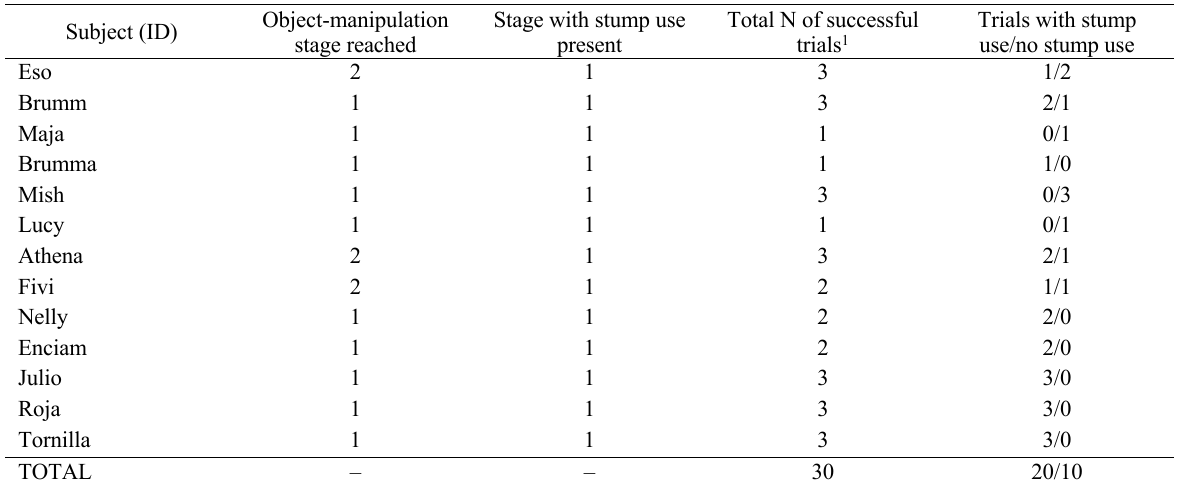
Results of the Object-Manipulation Trials, Including Number of Variations Presented and Presence/Absence of Stump Use